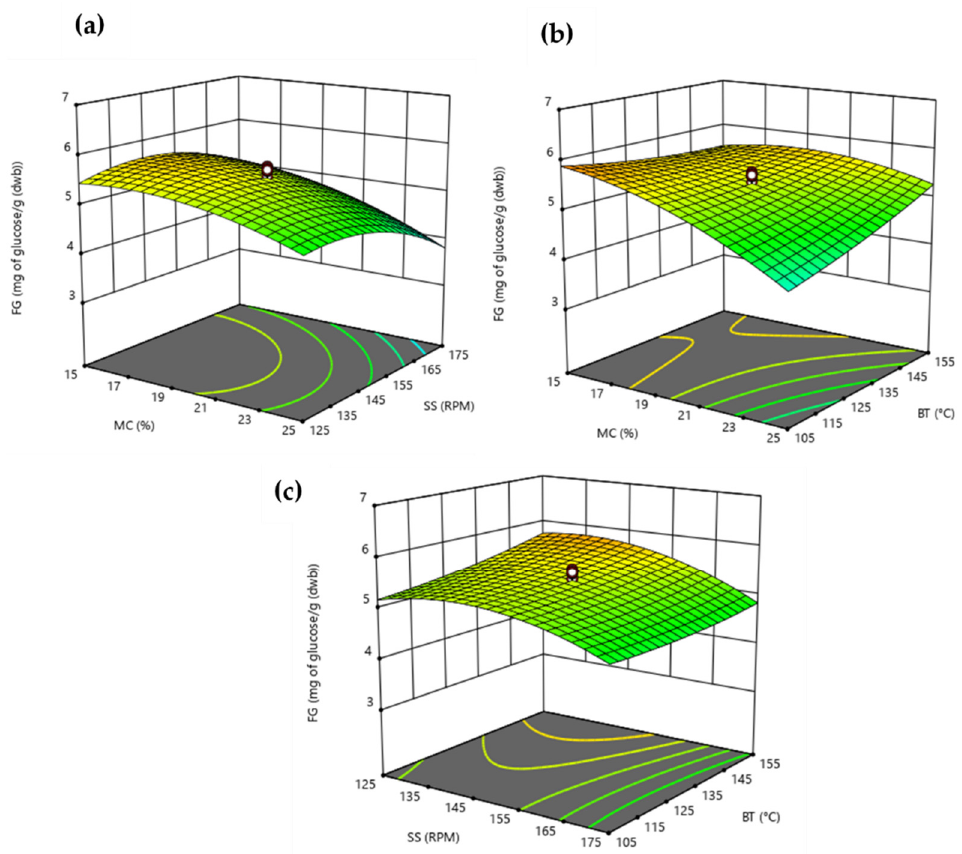
Figure 2. Response surface plots showing the effects of ( a ) moisture content (MC) and screw speed (SS), ( b ) moisture content (MC) and barrel temperature (BT), and ( c ) barrel temperature (BT) and screw speed (SS) on free glucose content (FG).